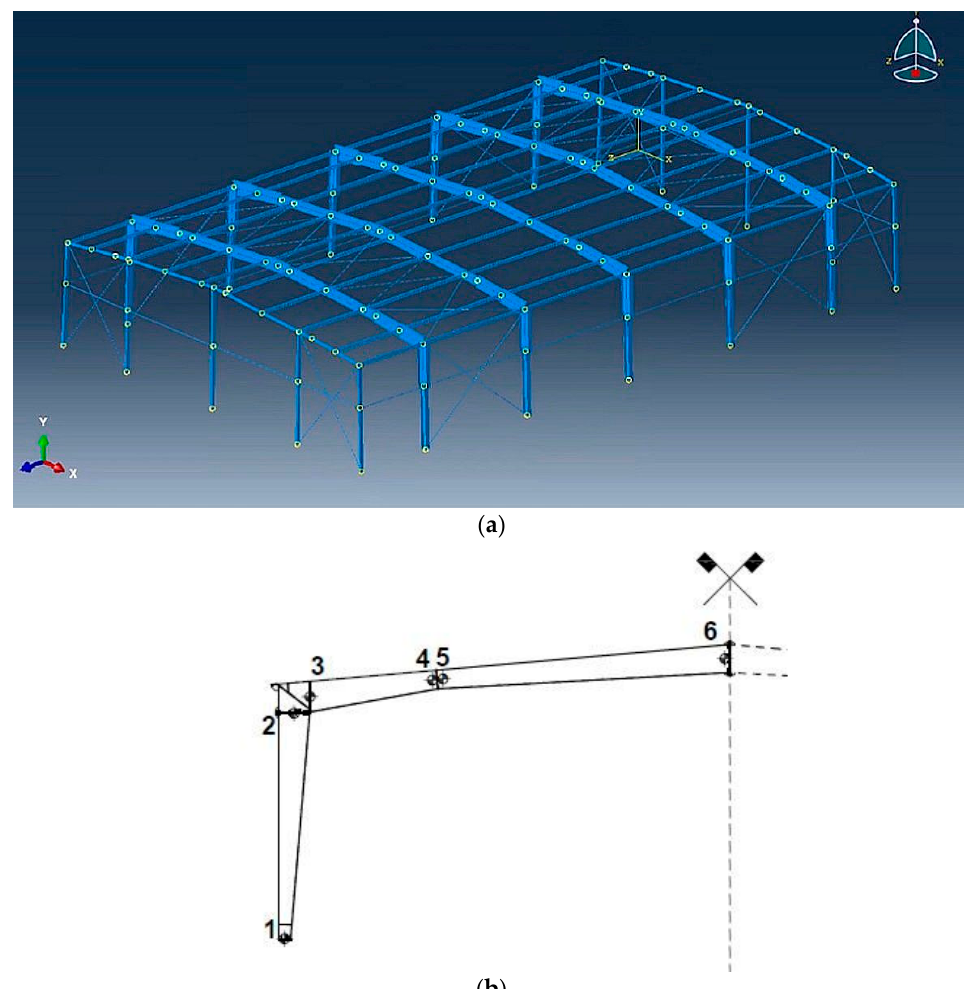
Figure 1. ( a ) Steel hall geometry overview. ( b ) Location of cross-sections described in Table 1. FEM analyses were performed using the beam finite elements B32OS consisting of 3